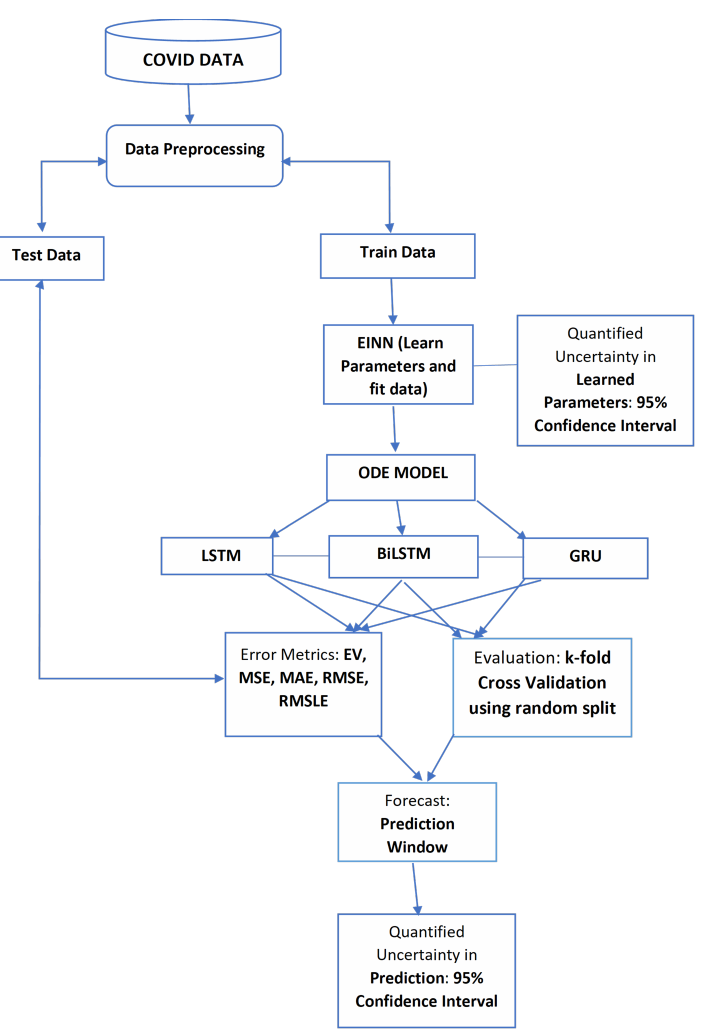
Figure 6. Deep learning forecasting workflow.